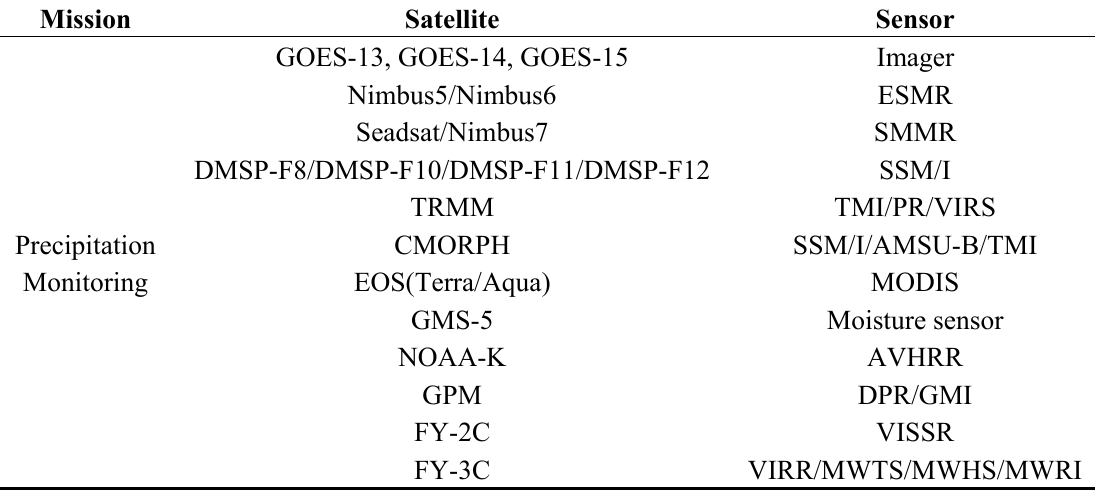
Table 2. Candidate remote-sensed dataset for precipitation monitoring.